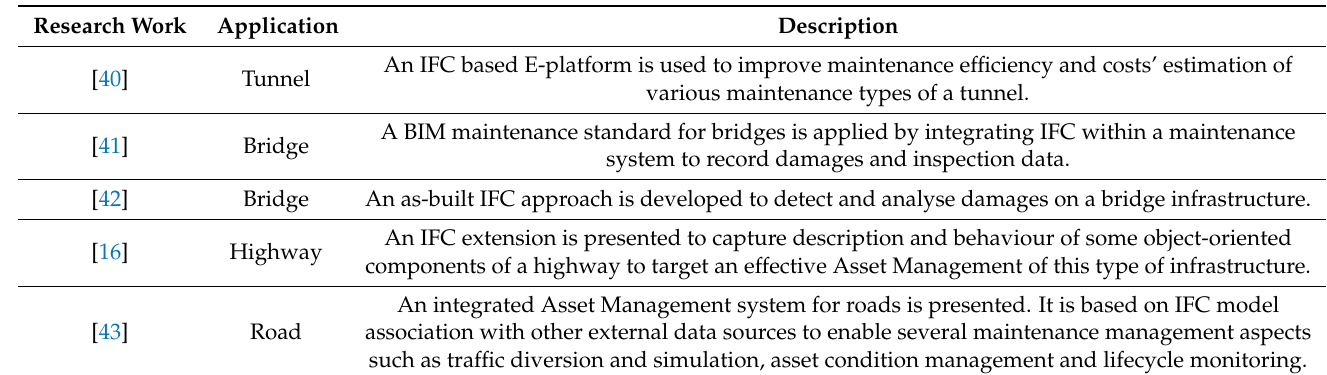
Table 4. Examples of OpenBIM applications in the field of O&M for